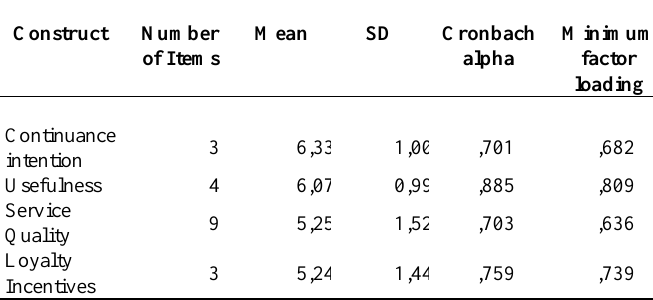
Table 2: Instrument reliabilities and validities